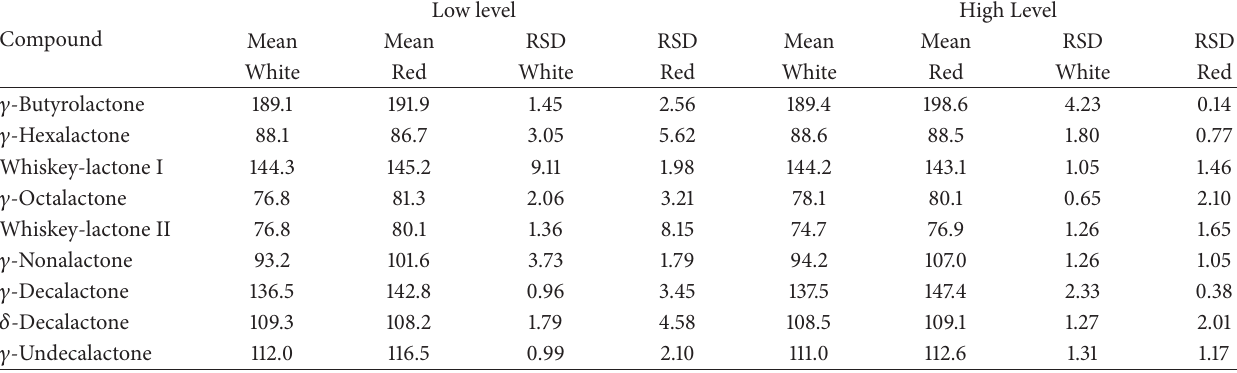
Table 7: Mean (%) and RSD (%) of recoveries.